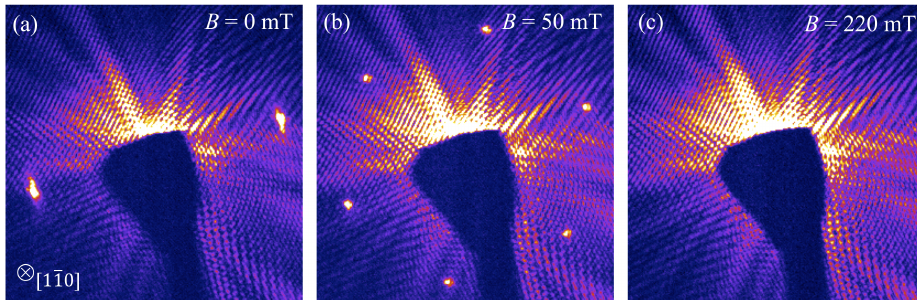
Figure 3. Resonant soft X-ray scattering (RSXS) patterns measured at T = 280 K and ( a ) B = 0 mT corresponding to the helical phase of FeGe; ( b ) B = 50 mT corresponding to the skyrmion crystal (SkX) phase; and ( c ) field-polarized state at B = 220 mT.